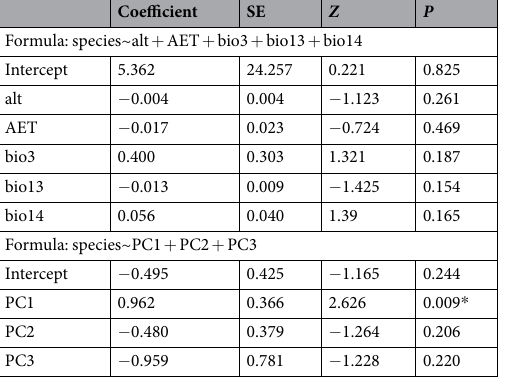
Table 3. Multivariate logistic regression to test the effect of environmental variables on species differentiation. * P <